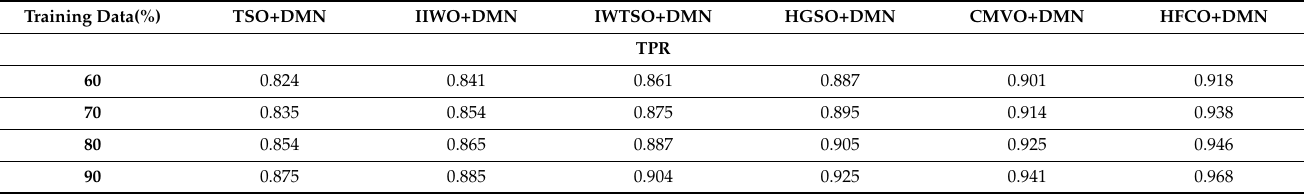
Table 10. Analysis based on optimization using Real-time dataset for TPR, TNR, FNR, precision, and testing